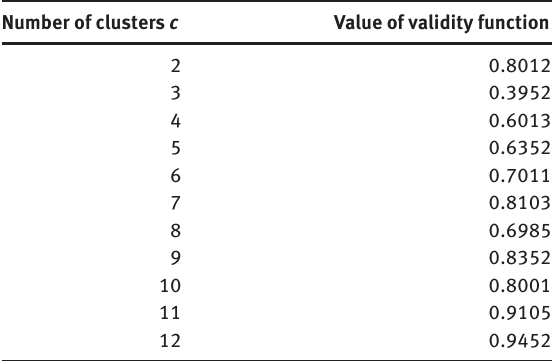
Figure 3. Comparison of the Conventional and Improved FCM Algorithms. Table 4. Values of Validity Functions for Various Numbers of